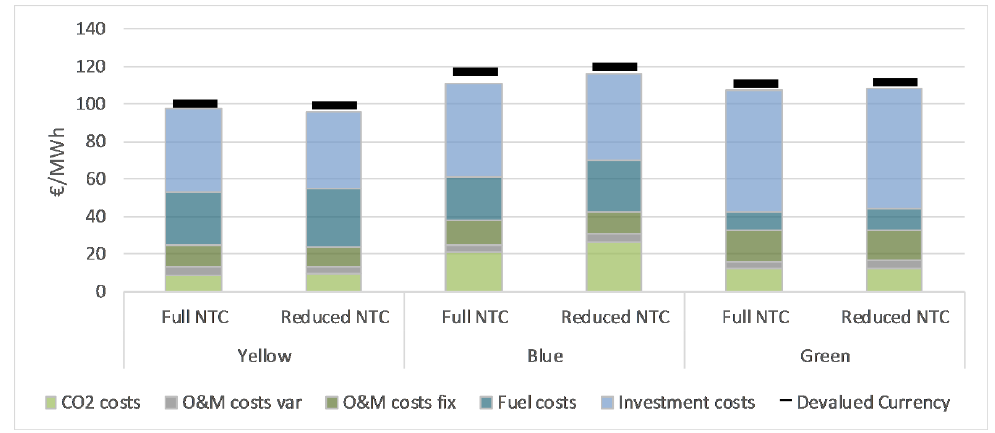
Figure 7. Average levelized costs of electricity generation. Source: Own calculation.